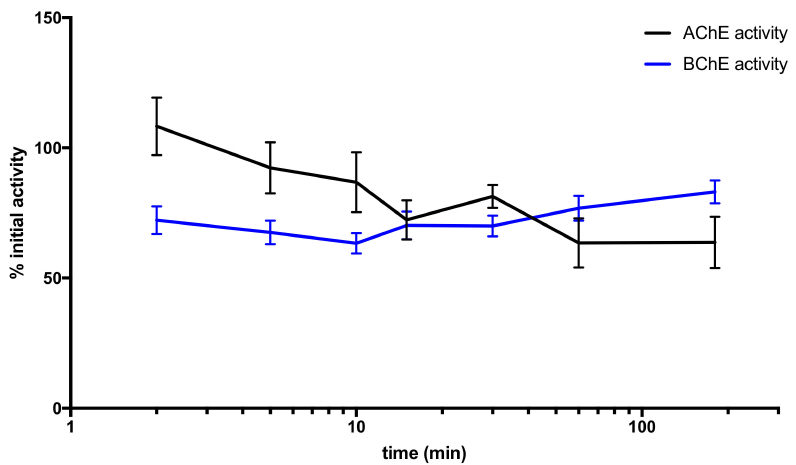
Figure 4. Mice blood AChE and BChE activity follow-up after an i.p. administration of 100 µ mol / kg KM297 HCl ( n = 8–10). Blood samples were drawn at various time points (0, 2, 5, 10, 15, 30, 60, and 180 min) after treatment, and AChE and BChE activity levels were measured. Values are presented as percentages of corresponding initial activity and points are means ± SEM.